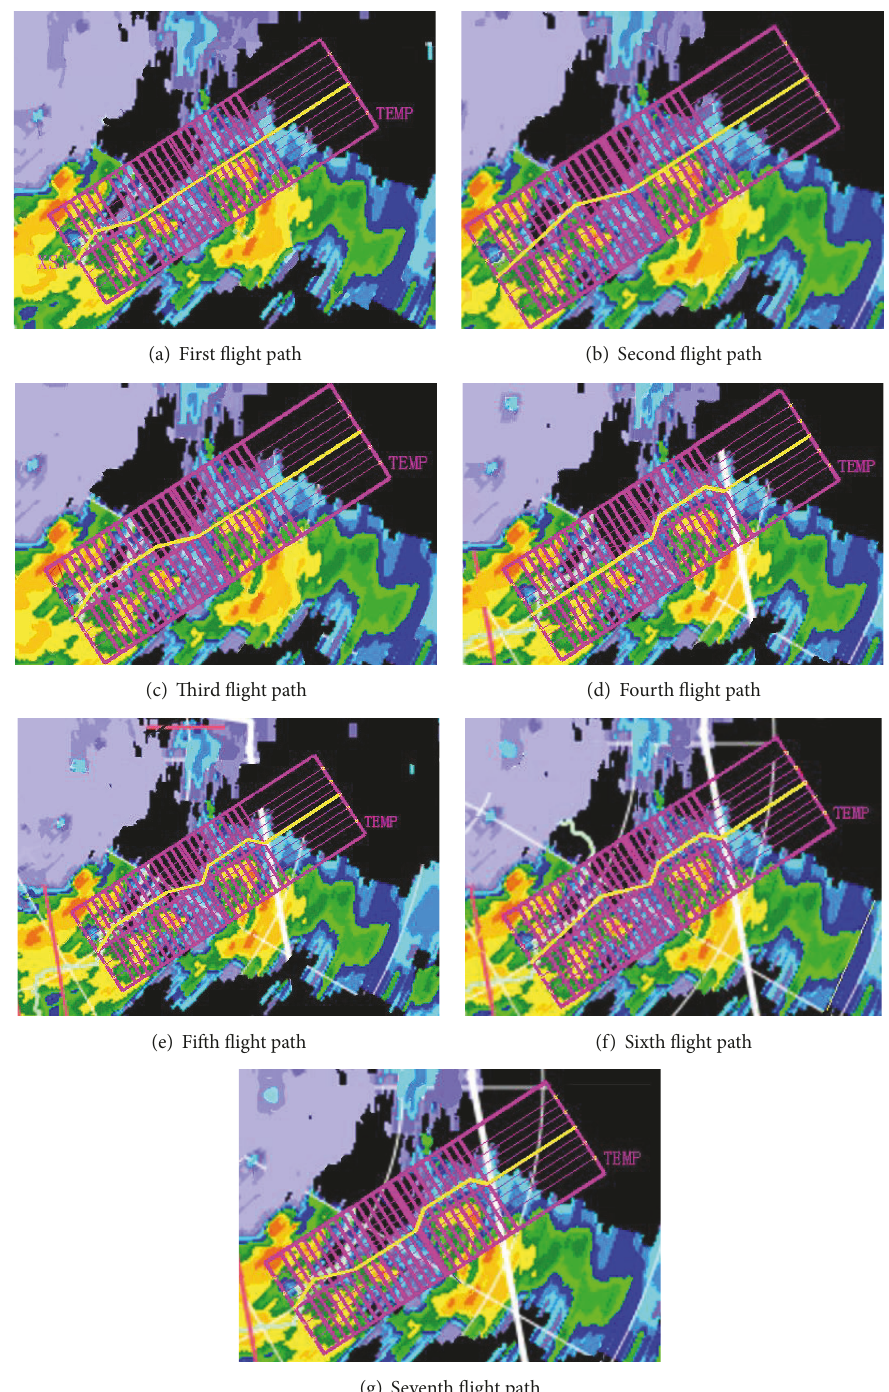
Figure 10: Flight paths to avoid the restricted thunderstorm